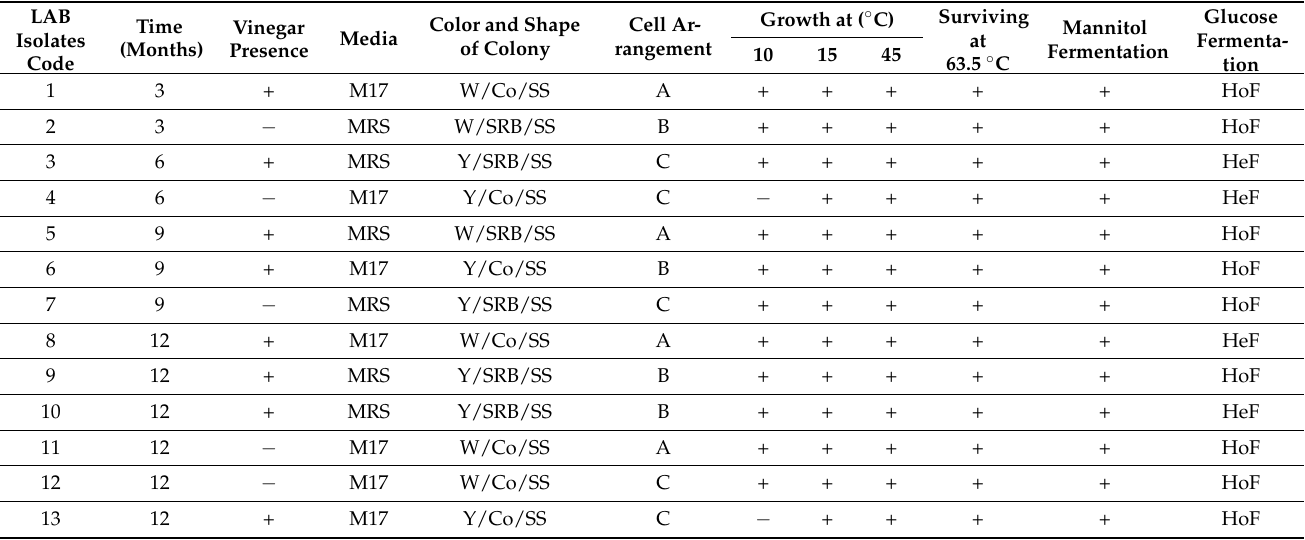
MRS (deMan, Rogosa and Sharpe Medium) and M17: bacterial growth medium for LAB; W: white; Y: yellow; Co: cocci; SRB: short rod bacilli; SS: smooth and shiny; A: short and long chain; B: pairs and chain; C: pair, tetrad and short chain; HoF: homo-fermentative; HeF: hetero-fermentative; +: positive result; − : negative